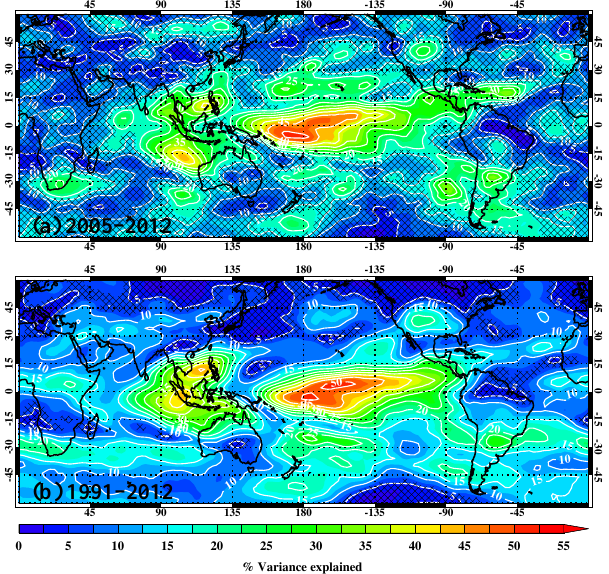
Figure 10. The deseasonalized TCO variance explained by ENSO in the GMI CTM simulation for years (a) 2005–2012 and (b) 1991– 2012. Crosshatched areas denote where the confidence level of the explained variance being different from zero is less than 95%. The increment of the white contours is